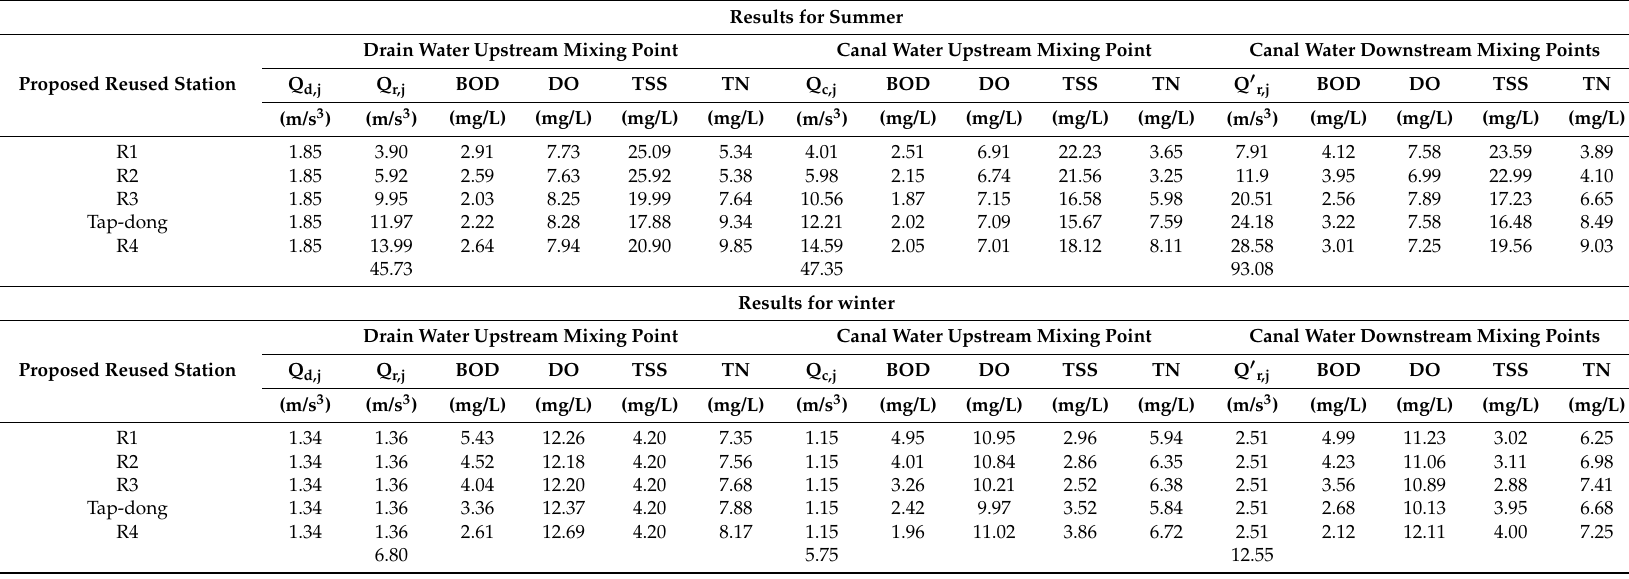
Table 5. Jaya Algorithm results at proposed reuse stations during summer and winter